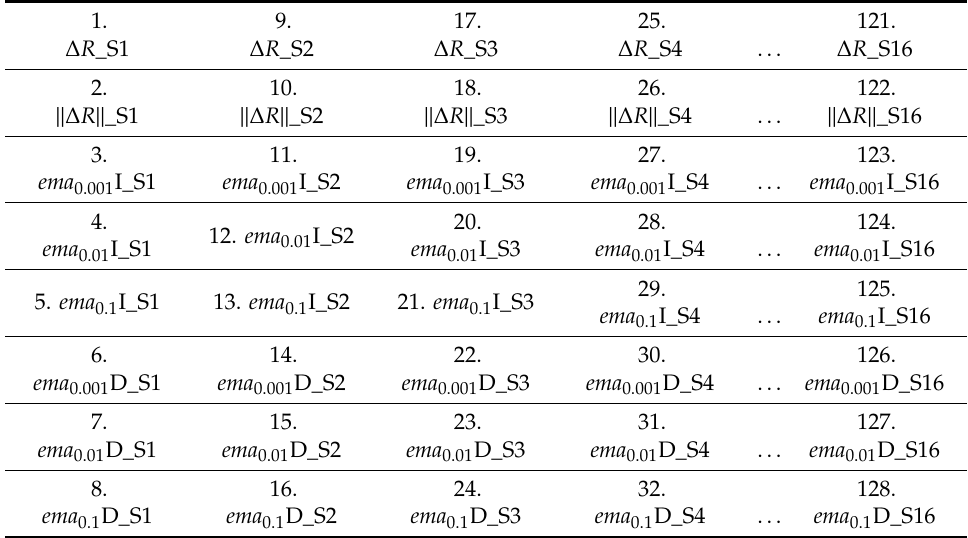
Table 2. Placement Order of Extracted Features in the Feature Vector.